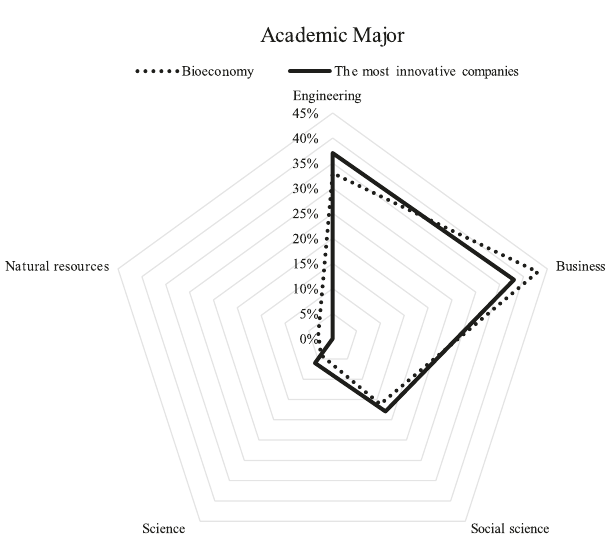
Fig. 1 Radar chart of types of education for the executive team members in both company groups. Educational disciplines for bioeconomy companies (dotted line) and the most innovative companies (solid line).